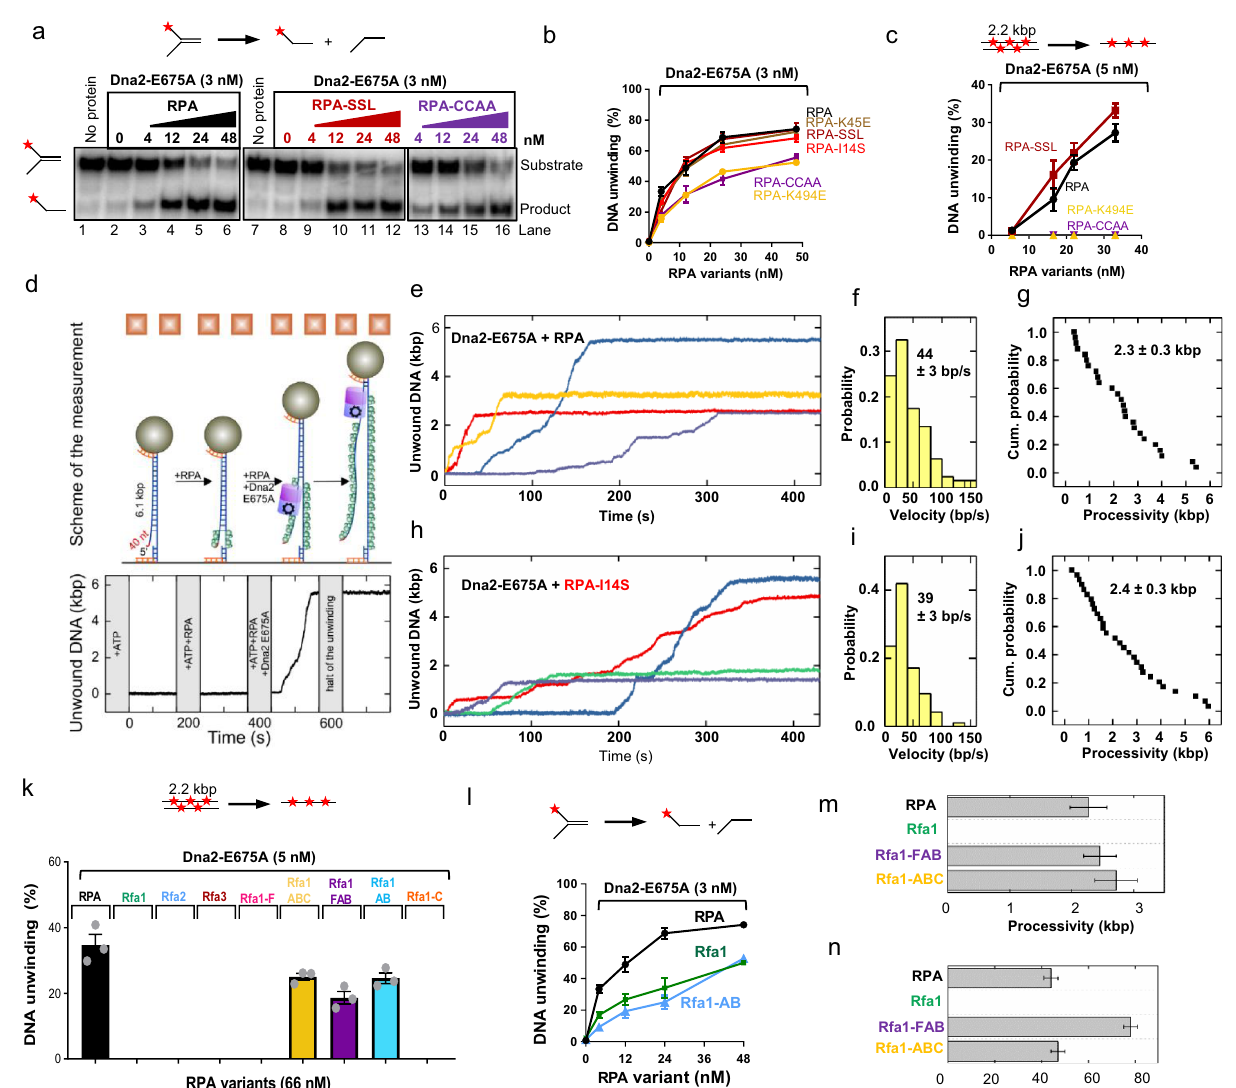
Fig. 5 RPA-I14S and RPA-SSL mutants promote the Dna2-E675A helicase. a Unwinding of a Y-shaped DNA substrate (45 nt ssDNA, 48 bp dsDNA 0.1 nM, in molecules) by Dna2-E675A in the presence of RPA variants and 50 mM KCl. The red asterisk indicates the position of the radioactive label. b Quanti fi cation of assays such as shown in panel a . Error bars, SEM; n = 3. c Quanti fi cation of 2.2-kbp-long dsDNA substrate (0.1 nM, in molecules) unwinding by Dna2-E675A in the presence of RPA variants. Error bars, SEM; n = 3. d A sketch of the employed magnetic tweezers assay including the DNA construct carrying a 40-nt-long 5 ′ -ssDNA fl ap to allow loading of Dna2-E675A (top). DNA unwinding trajectory with sequential addition of reagents revealing that DNA unwinding was only observed after the addition of Dna2-E675A. e Representative trajectories of DNA unwinding events by Dna2- E675A (5 nM). The reaction was supplemented with RPA (20 nM). f , g Velocity histogram and cumulative probability distribution (shown as survival probability) of the processivity obtained from DNA unwinding trajectories of Dna2-E675A in presence of RPA. Error, SEM; n = 25. h Representative trajectories of DNA unwinding by Dna2-E675A (5 nM). The reaction was supplemented with RPA-I14S (20 nM). i , j Velocity histogram and cumulative probability distribution (shown as survival probability) of the processivity obtained from DNA unwinding trajectories of Dna2-E675A in presence of RPA- I14S. Error, SEM; n = 29. k Quanti fi cation of 2.2-kbp-long dsDNA substrate (0.1 nM, in molecules) unwinding by Dna2-E675A in the presence of RPA, subunits of RPA and fragments of Rfa1, as indicated. Error bars, SEM; n = 3. l Quanti fi cation of Y-shaped DNA substrate (45 nt ssDNA, 48 bp dsDNA 0.1 nM, in molecules) unwinding such as shown in Supplementary Fig. 5c. RPA is replotted as in panel b for reference. Error bars, SEM; n = 3. m Bar graph Fig. 5g, j and Supplementary Fig. 5f, i. Error, SEM; n = 25, 25, 30 and 22 for RPA, Rfa1, Rfa1-FAB and Rfa1-ABC. Representative traces are shown in Supplementary Fig. 5d, g. n Bar graph of velocities of DNA unwinding by Dna2-E675A (5 nM) in the presence of RPA variants (20 nM). The distribution of the data is shown in Fig. 5f, i and Supplementary Fig. 5e, h. Error, SEM; n = 25, 25, 30 and 22 for RPA, Rfa1, Rfa1-FAB and Rfa1-ABC. Representative traces are shown in Supplementary Fig. 5d,